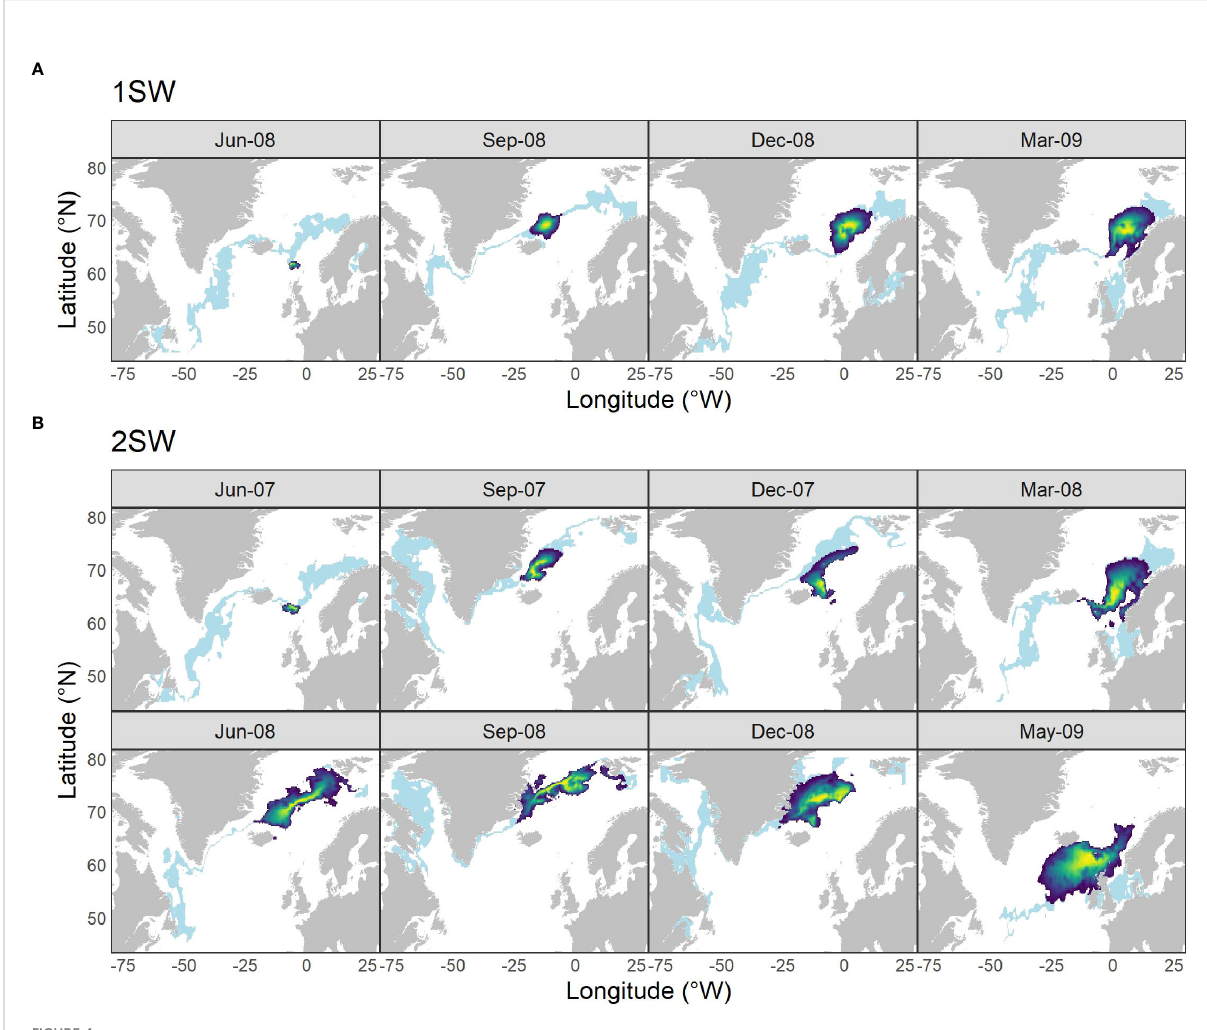
FIGURE 4 Locations of two wild Atlantic salmon at various time points during the marine migration inferred from otolith d 18 O derived water temperatures. The model was applied to one (A) 1SW and one (B) 2SW adult salmon for illustrative purposes. Light blue banding illustrates the distribution of all